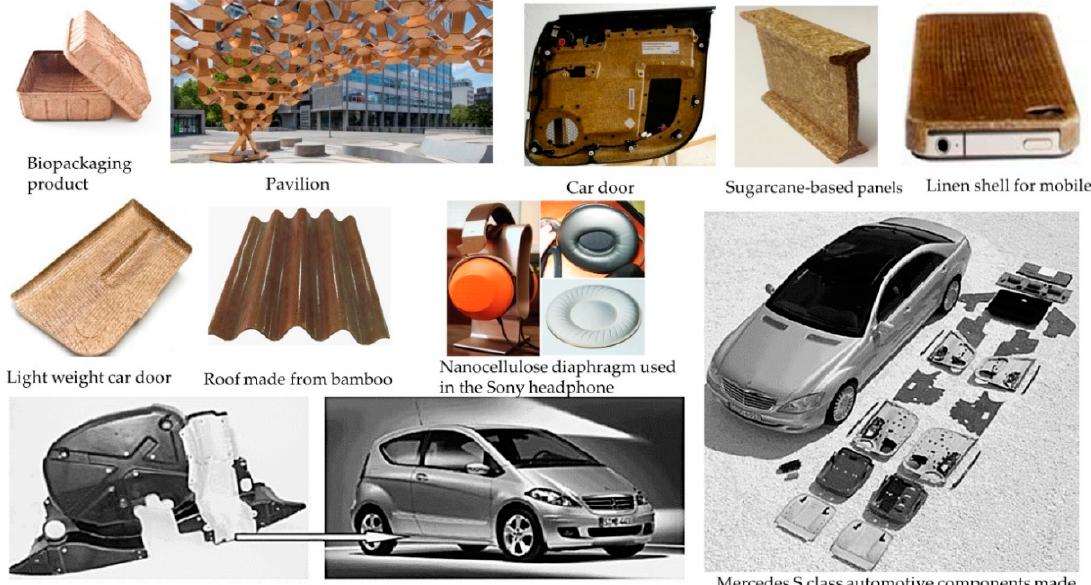
Figure 11. Different applications of BCs and NBCs. Under floor protection trims and S class of Mercedes are produced with the permission from Elsevier, 2008; Nanocellulose diaphragm (2011) was reprinted with the permission from author [171 – 179] .